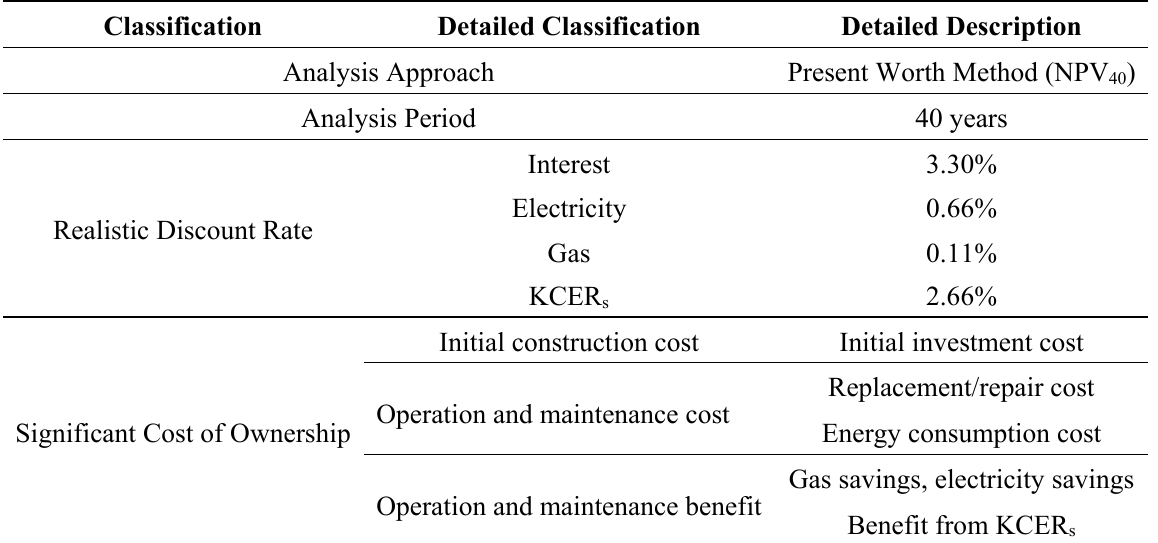
Table A6. Boundary conditions of LCC and